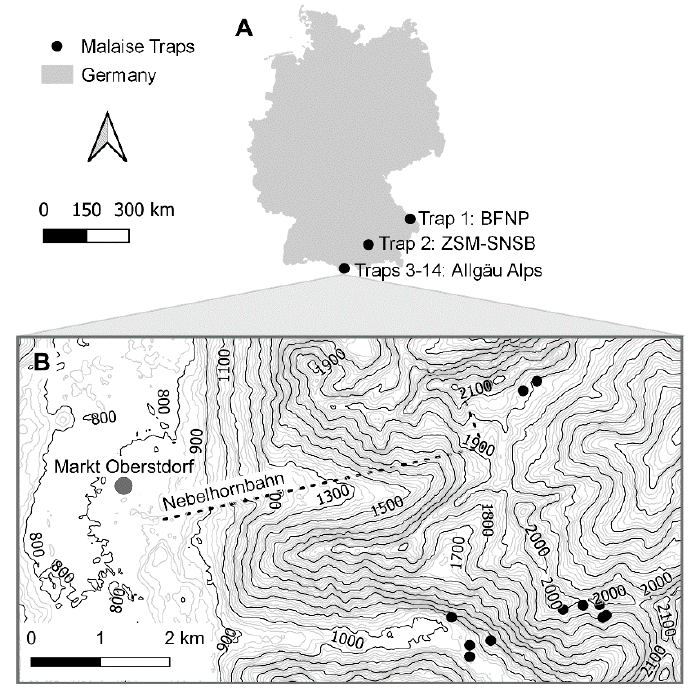
Figure 2. Malaise trap sites. Locations where the 14 Malaise traps were deployed in 2012, 2014, and 2017 (( A ), ( B ) shows enlarged map of Allgäu Alps) as Germany’s contribution to the Global Malaise Trap Program. Table 1. Malaise trap information. Trap site, exact location, elevation, and habitat type.